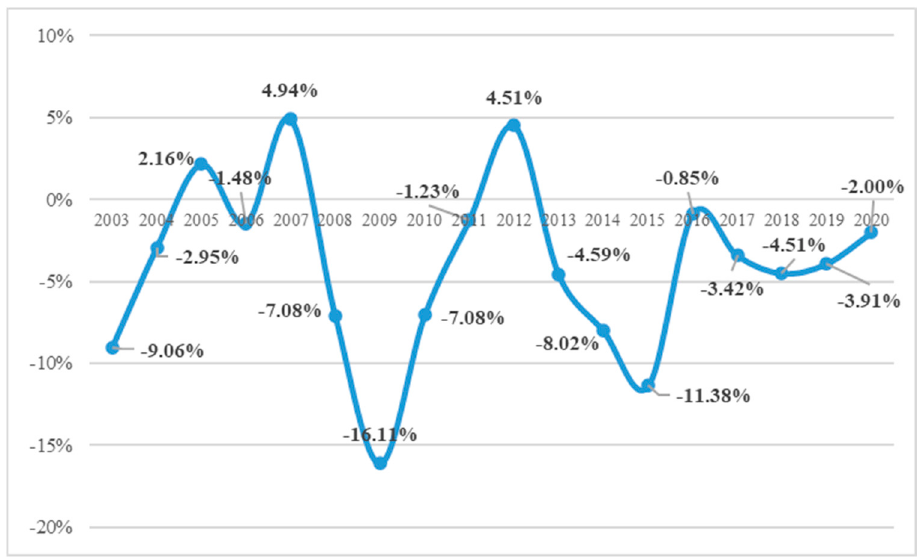
Figure 5. Ratio of the budget deficit/surplus to the annual budget revenues for 2003-2020 (in %) for the city of Zabrze. Source: own elaboration. Table 2. Statistics for deficits/surpluses of the examined cities.